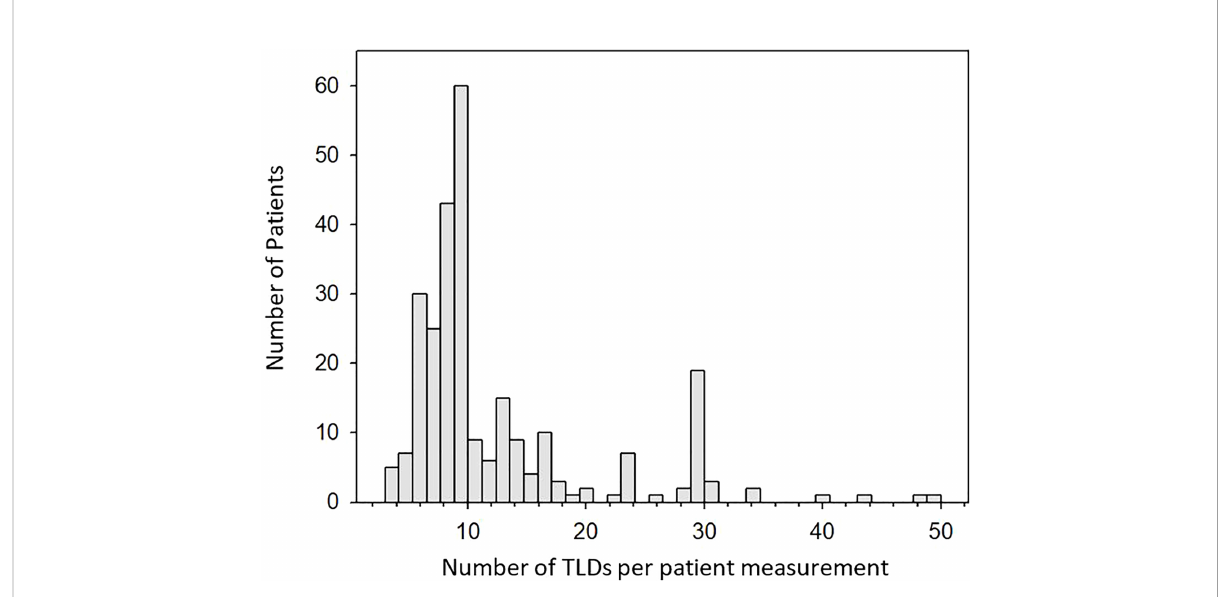
FIGURE 4 Histogram showing the number of TLDs used per patient measurement. Up to 10 TLDs are often used for conventional cases. The peak at 30 TLDs is a result of TBE treatments which in rare cases can also require up to 50